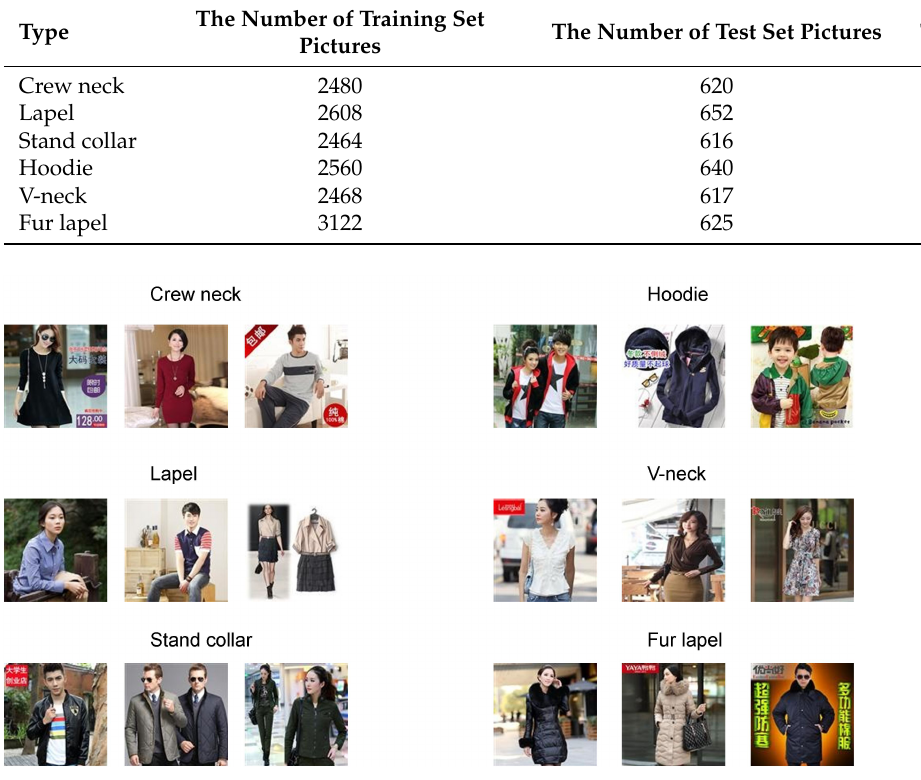
Table 3. Data distribution for the Collar6 dataset.